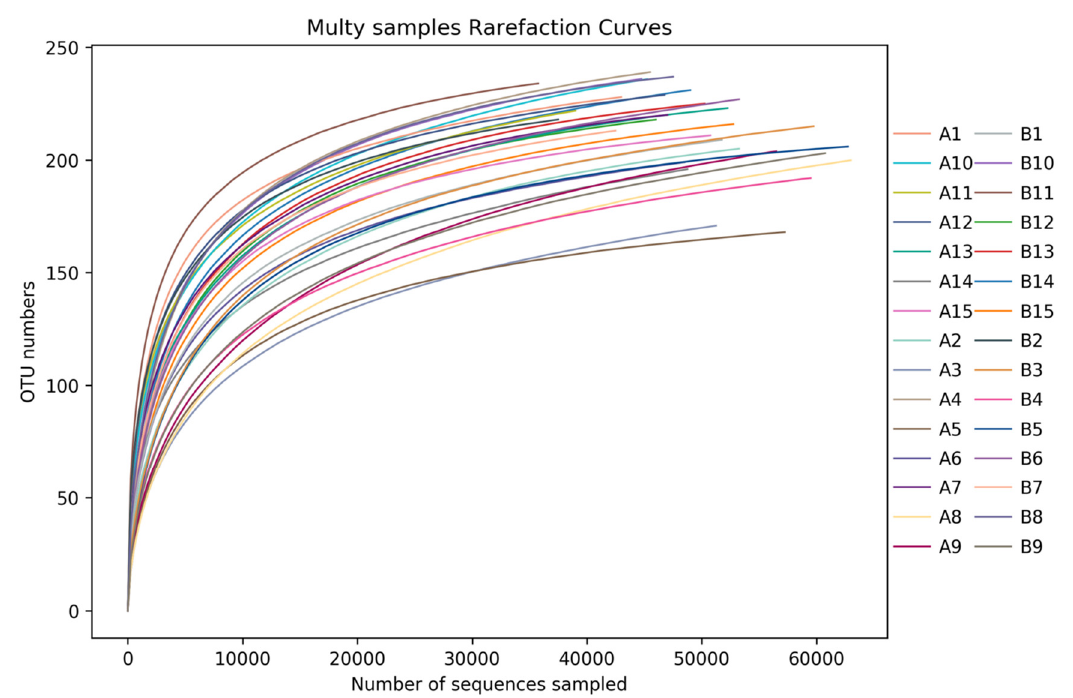
Figure 19. Rarefaction curve of each sample fosr each group. Abscissa was the number of sequences, and ordinates represented the number of OTU in sequence clustering. The curves of different colors represented various